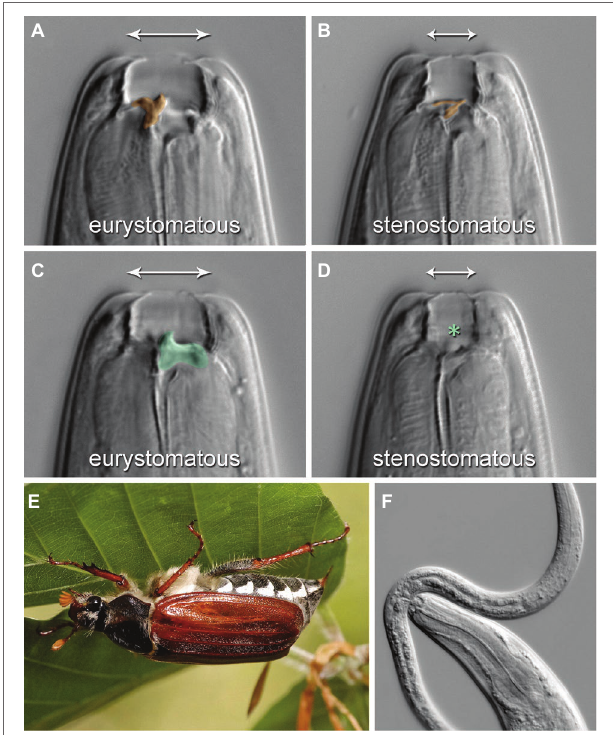
FIGURE 3 | Mouth-form polyphenism in P. pacificus Nematodes. (A,C) are a single Eu individual in two focal planes, whereas (B,D) are a single St individual in the corresponding planes. (A,B) are sagittal, (C,D) right sublateral planes. The Eu form bears a claw-like dorsal tooth [ (A) , false-colored orange] and an opposing, claw-like right subventral tooth [ (C) , green], whereas the St form has a thin, flint-shaped dorsal tooth [ (B) , orange] and no subventral tooth [ (D) , asterisk]. The mouth-form polyphenism also includes mouth breadth (indicated by arrows). (E) The mouth-form polyphenism imparts novel feeding abilities that foster a necromenic association with scarab beetles, including the European cockchafers ( Melolontha spp.), cadavers of which are host to diverse microorganisms used as food. (F) The complex structures of the Eu form are associated with the ability to prey on other nematodes, as pictured by an Eu P. pacificus individual attacking a Caenorhabditis elegans larva. (Reproduced with permission from Ragsdale et al.,